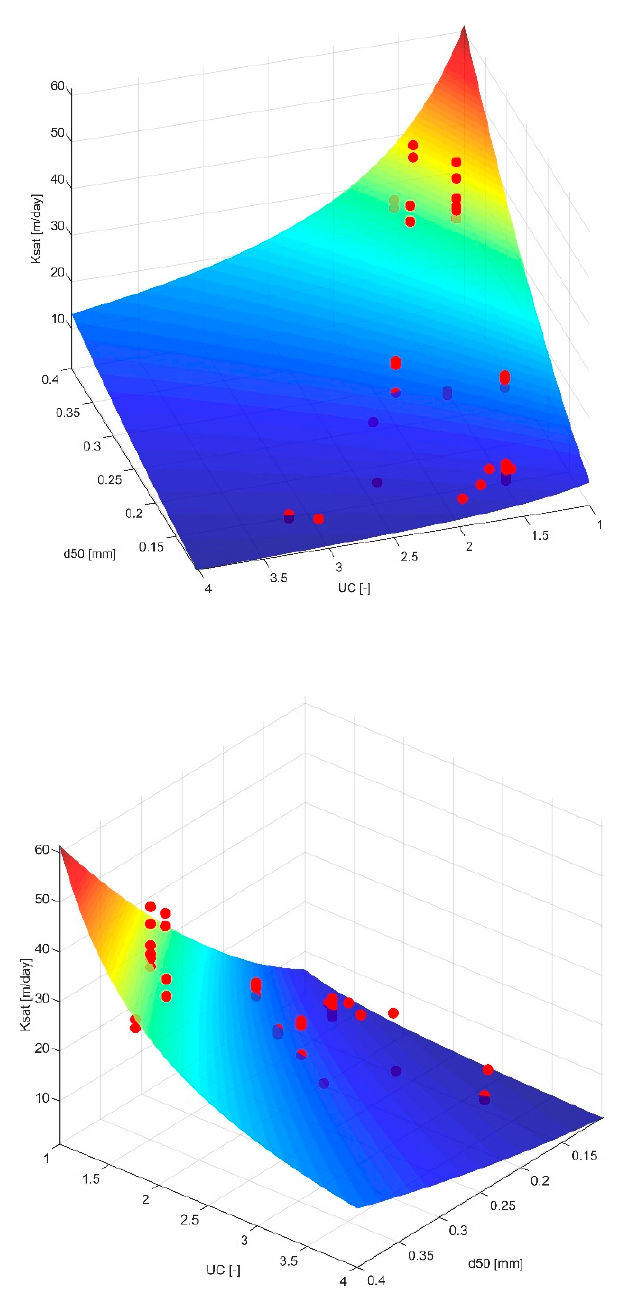
Figure 6. 3D representations of the fit of Equation (3) for saturated conductivity (m / s) versus Uc and D50 (m), compared to the database (scatterplot). Scale bar represents the saturated conductivity. The change in slope over an increasing D50 shows the increased effect of Uc with a larger median grain size.